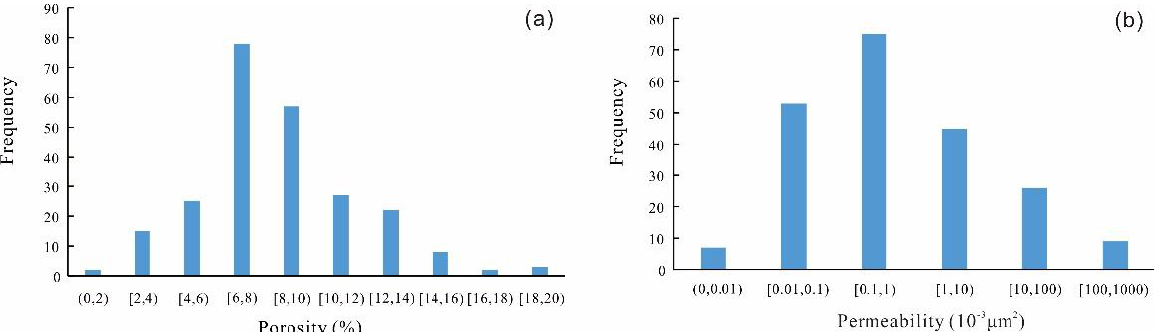
Figure 3. Distribution frequency histogram of porosity ( a ) and permeability ( b ) of Lower Wuerhe formation.